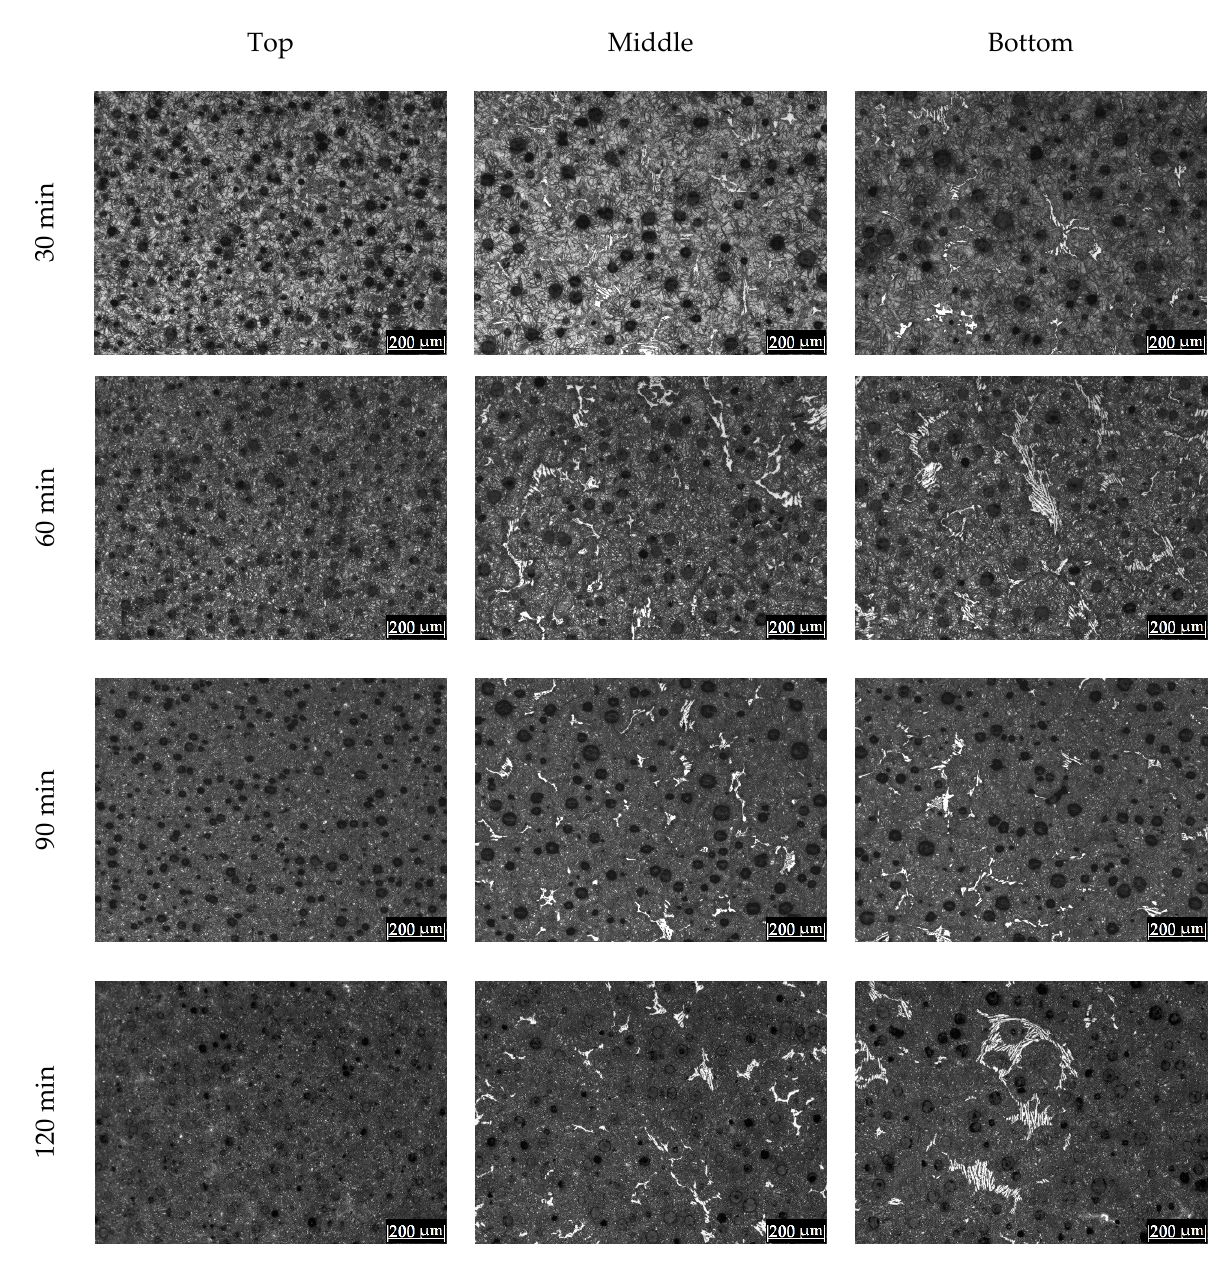
Figure 7. Microstructural evolution for the CADI-0.4Cr-305 sample at the austempering times of 30, 60, 90, and 120 min for the three regions analyzed.